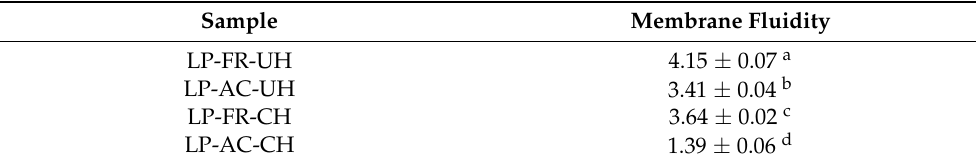
All data are represented as mean ± SD. Different letters (a, b, c, d) reveal the significant differences ( p < 0.05)